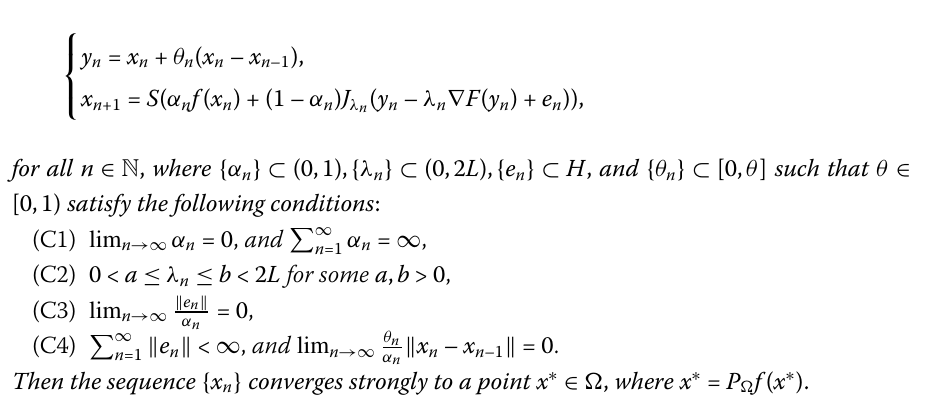
sequence generated